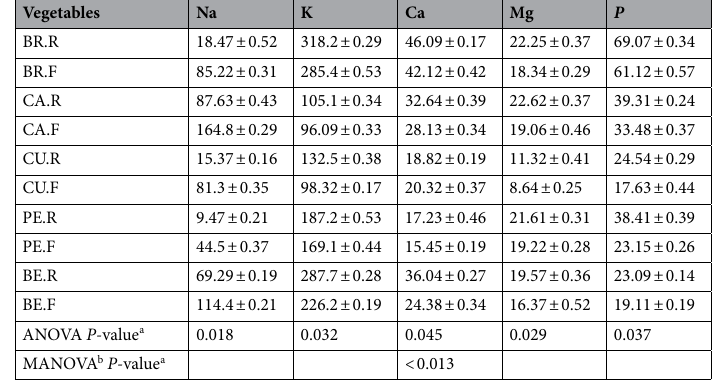
Table 5. Macroelements in raw and fermented vegetables (g·kg −1 fresh matter). The results are the mean ± standard deviation of four repetitions (n = 4) of each vegetable combination. a P < 0.05 statistical differences. b Raw/fermented vegetables.